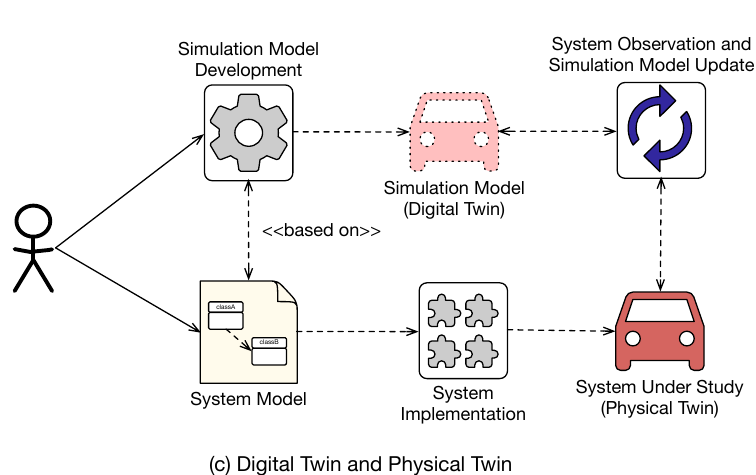
Figure 1. Traditional M&S Approaches vs. Adoption of a Digital